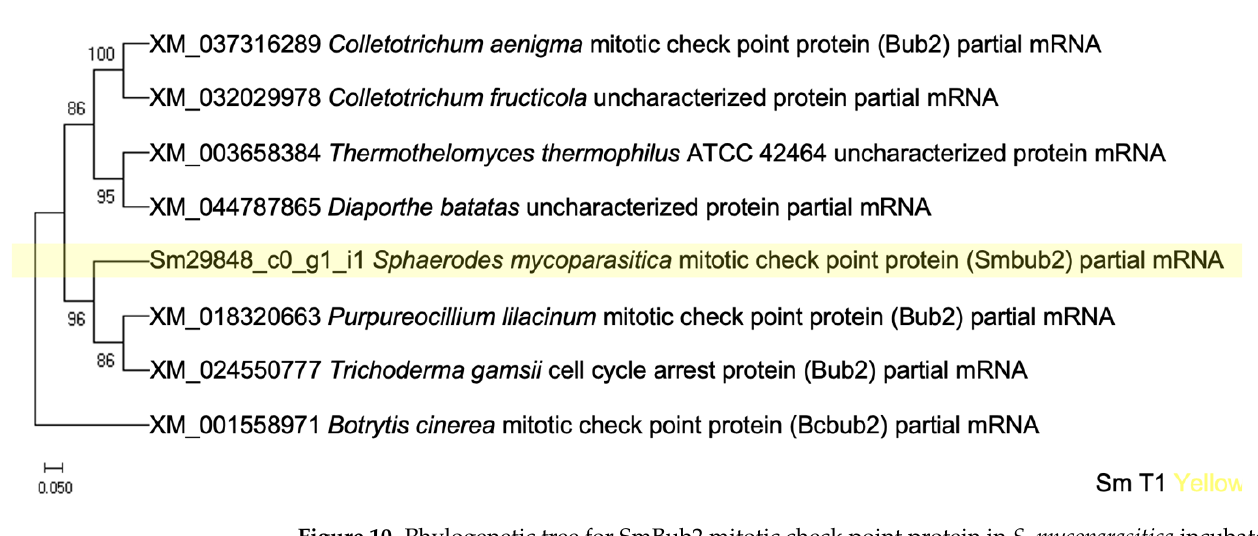
Figure 10. Phylogenetic tree for SmBub2 mitotic check point protein in S. mycoparasitica incubated for 1.5 days in interaction with Fusarium graminearum 3-ADON host. The branch support bootstrap values were obtained by 1000 replicates using the NJ method.